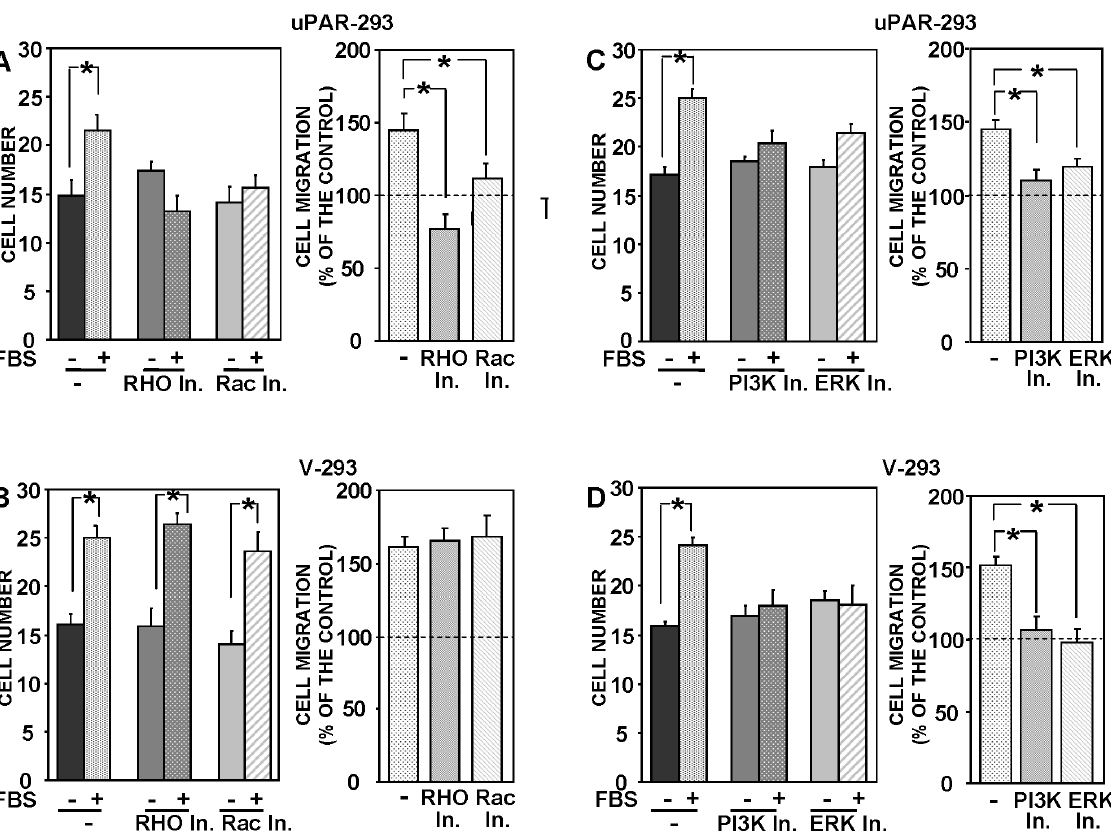
Figure 6. uPAR-dependent cell migration is mediated by signaling mediators not involved in uPAR-independent cell migration. uPAR-293 cells ( A and C ) or V-293 cells ( B and D ) were pre-incubated with diluents (-) or inhibitors of Rho- or Rac1-dependent signaling pathways ( A and B ), or with diluents (-) or inhibitors of PI3K or ERK-MAPKs ( C and D ). Cells were then plated in Boyden chambers and allowed to migrate toward 10% FBS. Migrated cells were fixed, stained with hematoxylin, and counted (left panels). The values are the mean 6 SD of three experiments performed in triplicate. (*) p # 0.05, as determined by the Student’s t test. Results of migration assays are also expressed as percentage of cells migrated towards serum over the cells migrated without serum; 100% values represent cell migration in the absence of chemoattractants (right panels). (*) p # 0.05, as determined by the Student’s t test.